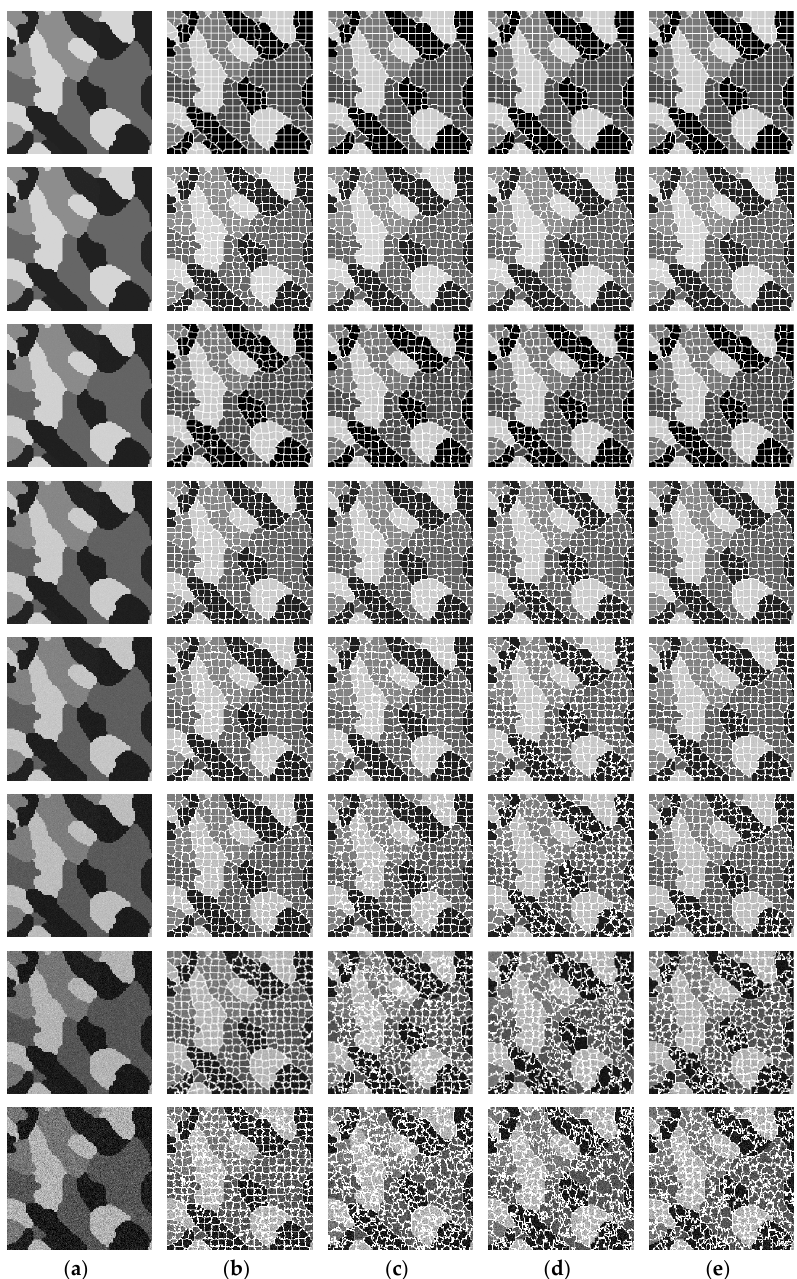
Figure 7. Superpixels generated by SSA, SLIC, SLIC-SAM, and SLIC-SCM from the synthetic HS image at various noise levels. ( a ) Original and noisy images with SDSINR = 1 and SNR = 800, 100, 50, 30, 20, 10, 5 from row 1 to the row 8; ( b ) superpixels generated by SSA from the corresponding images; ( c ) superpixels generated by SLIC from the corresponding images; ( d ) superpixels generated by SLIC-SAM from the corresponding images; ( e ) superpixels generated by SLIC-SCM from the corresponding images. SSA, superpixel segmentation algorithm; SLIC, simple linear iterative clustering; SLIC-SAM, SLIC-spectral angle mapping; SLIC-SCM, SLIC-spectral correlation mapper; SDSINR, SD-to-SI noise